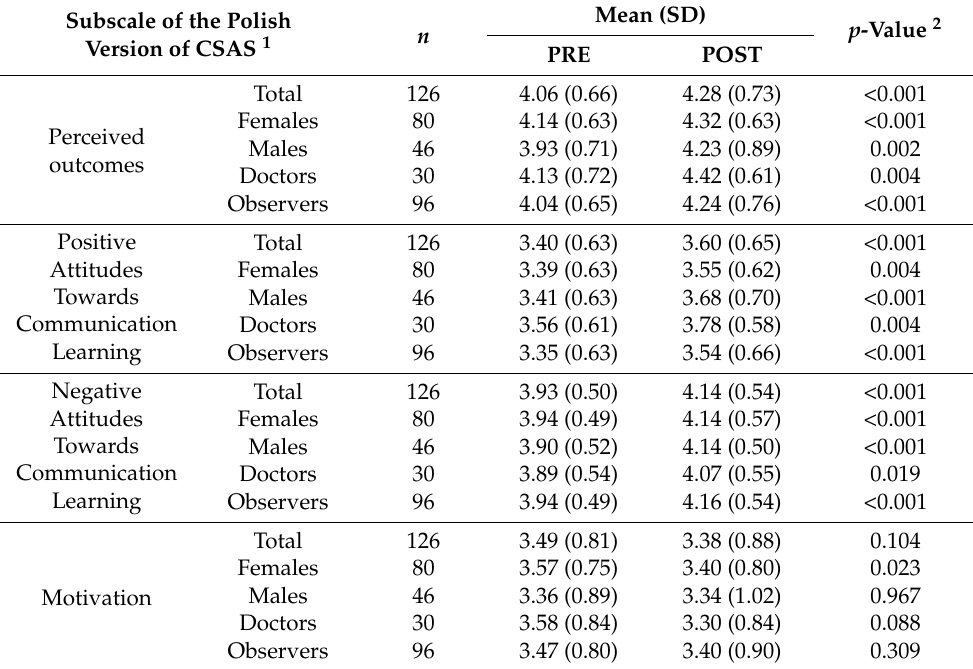
Table 1. The comparison of the CSAS subscales scores before and after the intervention.